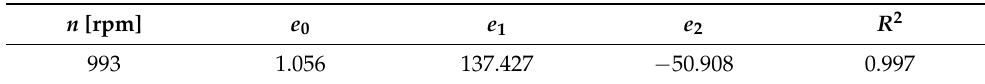
Table 9. The coefficients of the 2nd-degree polynomial approximation function for the efficiency η P = f ( Q ) of the 1MW Worthington pump at speed of 993 rpm.